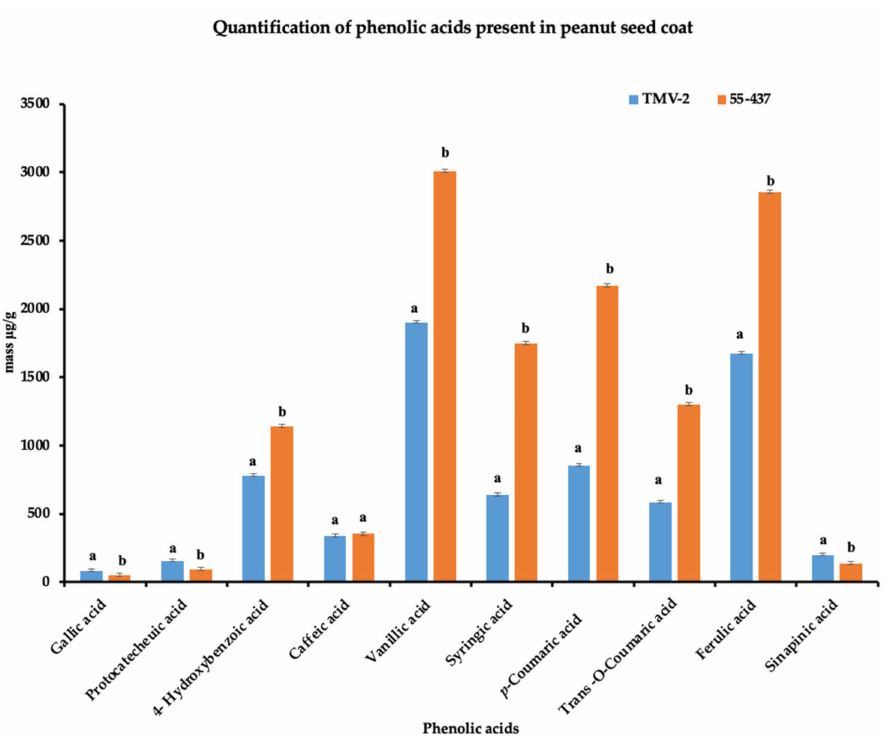
Figure 4. Quantification of peanut seed coat phenolic acids. Phenolic acids isolated from TMV-2 and 55-437 seed coats by SPE C-18 and NH2 cartridges (detection at 280 nm). Quantification was performed using the calibration curve. The quantified data are an average of 3 technical replicates and 3 biological replicates. The Students t -test was used to determine the significant difference between different groups. Means not sharing the same letter are significantly different ( p < 0.05), and error bars represent standard error ( n =